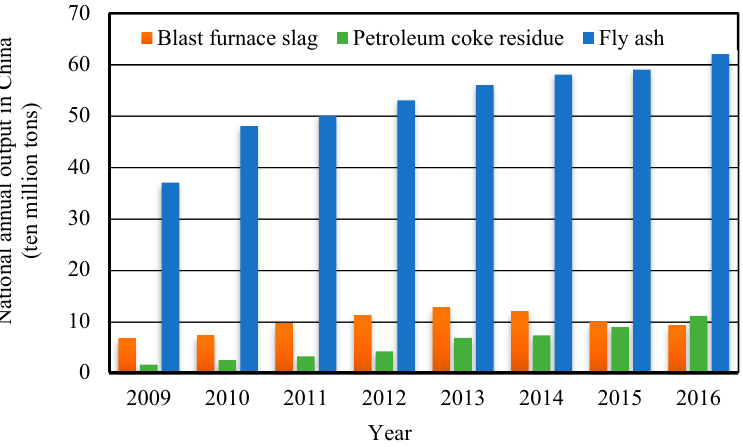
Figure 1. National annual output of industrial wastes. (Source: National Bureau of Statistics- Environmental Statistics Yearbook.)